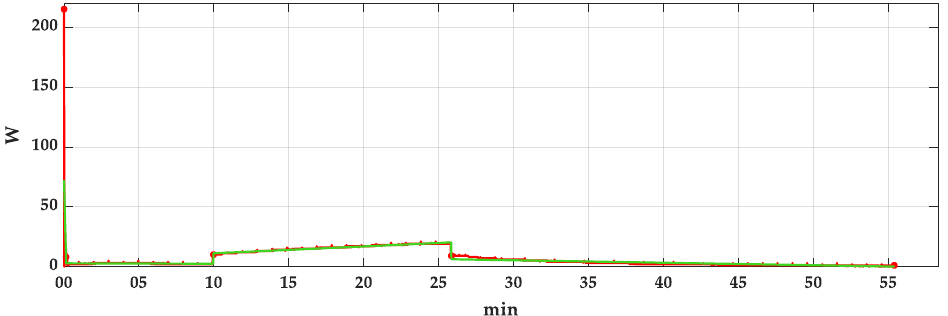
Figure 20. PWL approximation of the refrigerator ’s load profile — RMS value 3.16 (measured data — red vs. approximated profile — green).